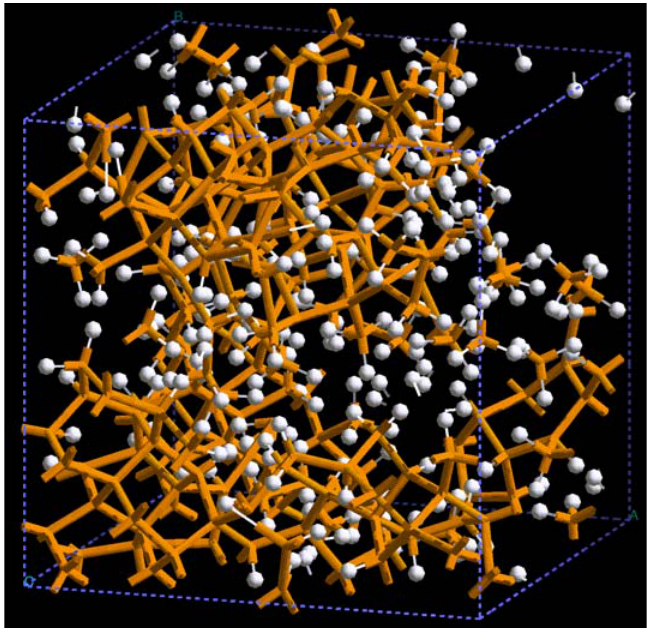
Figure 19. Starting with the relaxed amorphous porous silicon structure, the dangling bonds were saturated with 252 hydrogens. Next the supercell was geometry